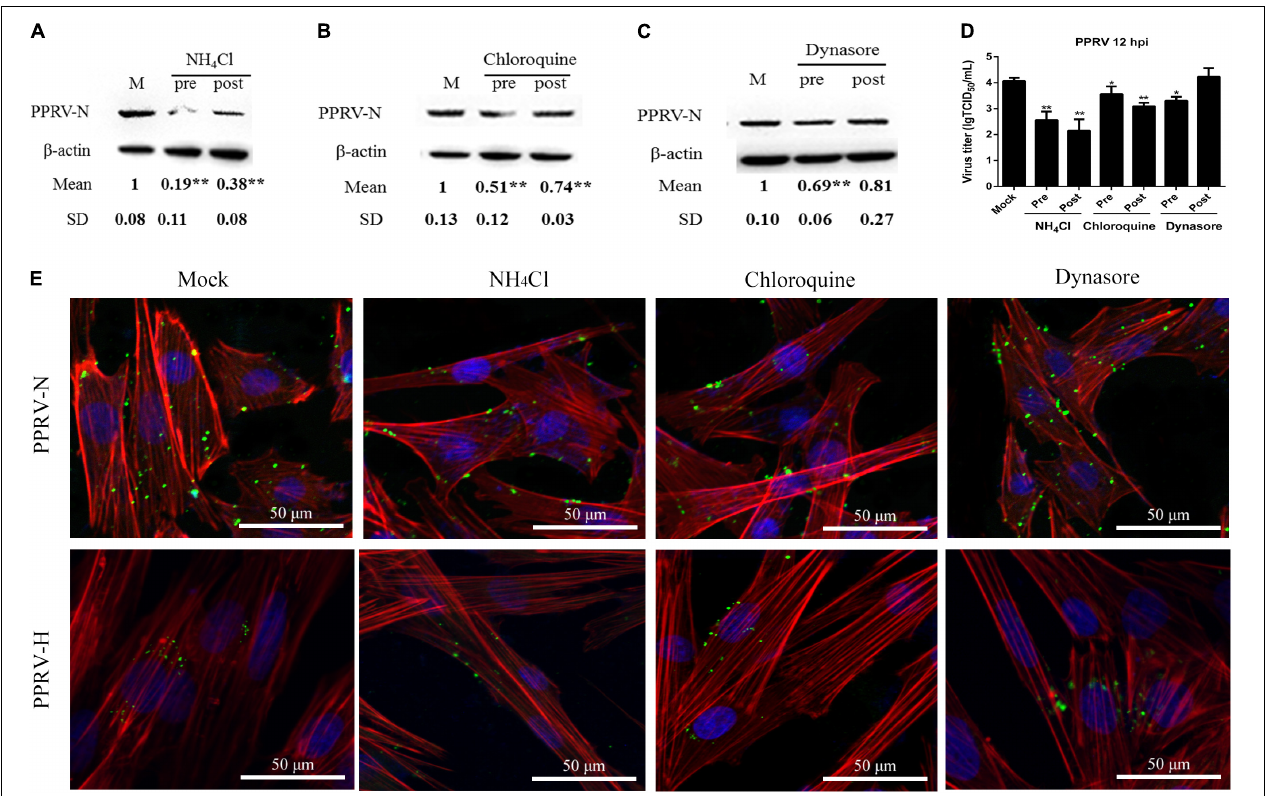
FIGURE 3 | Peste des petits ruminants virus (PPRV) entry depends on low pH and dynamin. (A–C) Western blot analysis of the entry of PPRV into mock-, NH 4 Cl-, chloroquine- or dynasore-treated cells. β -actin was used as an internal control. (D) Virus titration analysis of the entry and replication of PPRV in NH 4 Cl-, chloroquine- or dynasore-treated cells. (E) CLSM analysis of TRITC-phalloidin (red), anti-PPRV (green) and DAPI (blue) in PPRV-infected EECs pre-treated with NH 4 Cl, chloroquine or dynasore. The bars indicate the mean ± SD from three independent experiments. SD, standard deviation; ∗ P < 0.05; ∗∗ P <